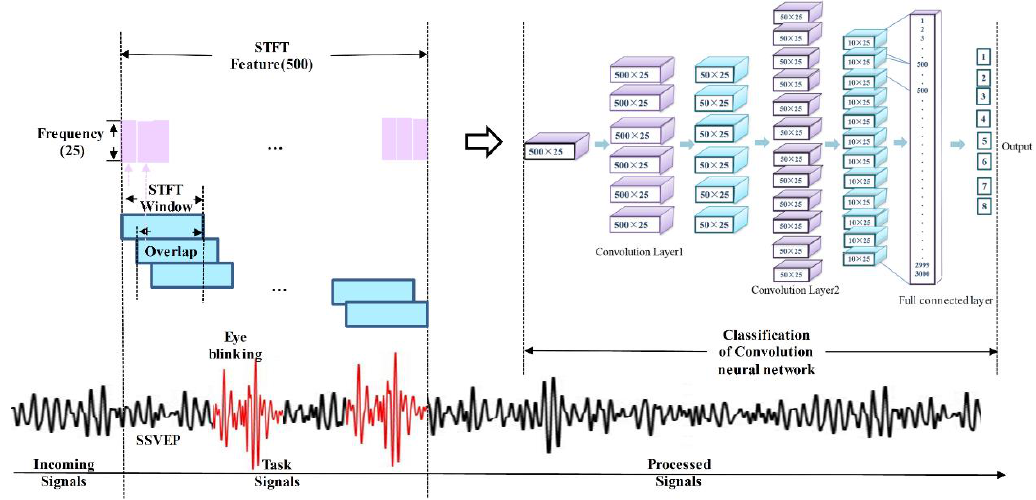
Figure 4. Procedure for signal acquisition, feature extraction, and classification.